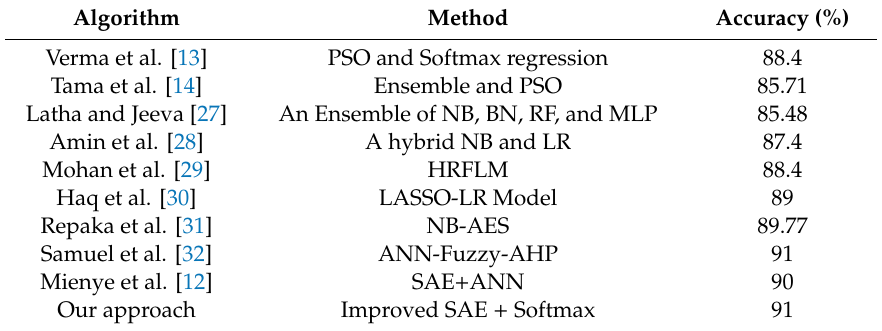
Table 4. Comparison of the proposed method with the recent literature that used the heart disease dataset.